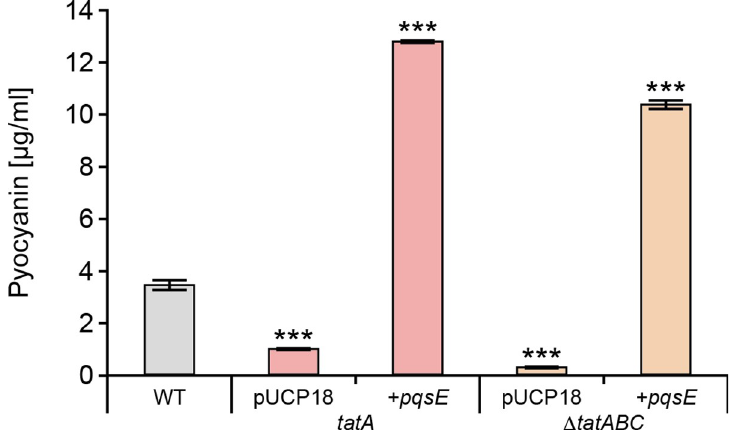
Fig 9. PqsE restores pyocyanin production in P . aeruginosa tat mutants. Production of pyocyanin by the wild type compared with the tatA and Δ tatABC mutants transformed with plasmid-borne pqsE or the empty vector. Experiments were repeated in triplicate at least twice. ��� p <